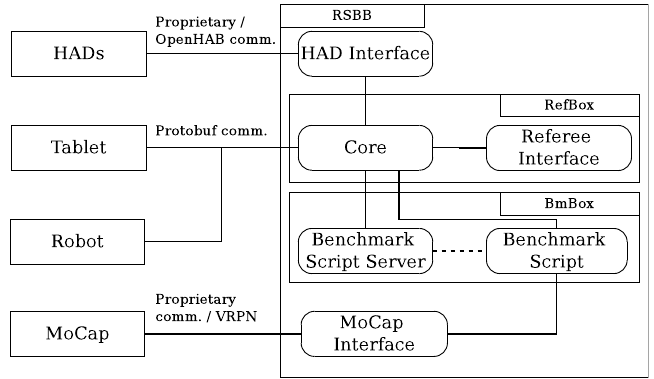
Figure 8. RSBB packages and communication